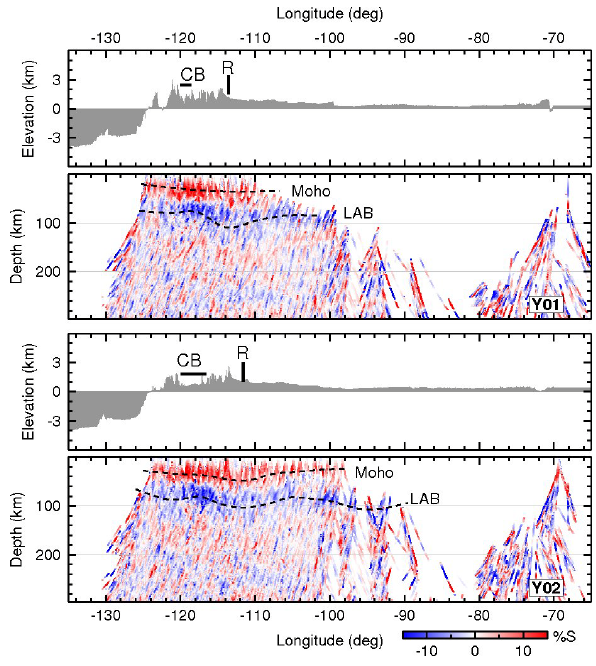
Fig. 3. Two migrated S receiver function profiles: Y01 and Y02, across the station network. Names of the profiles are given in the Two migrated S receiver function profiles, Y01 and Y02, across the station network. lower right. Moho (red, positive conversion) and LAB (blue, nega- tive conversion) are marked. Key: see Fig. 1. Dashed lines for Moho Names of the profiles are given in the lower right. Moho (red, positive conversion) and LAB are drawn by hand and mark approximately the depth dis- and LAB (blue, negative conversion) are marked. Key: see Fig. 1. Dashed lines for tribution of these discontinuities. The seismic data have been fil- tered with an 8s low-pass Moho and LAB are drawn by hand and mark approximately the depth distribution of these discontinuities. The seismic data have been filtered with an 8s lowpass filter.